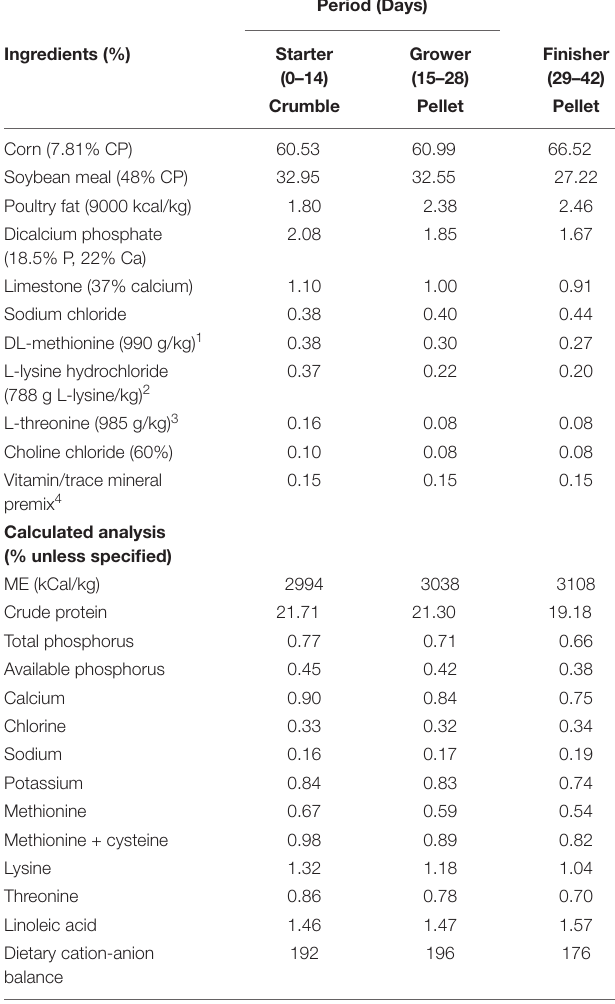
TABLE 1 | Composition of basal diets (as fed basis,